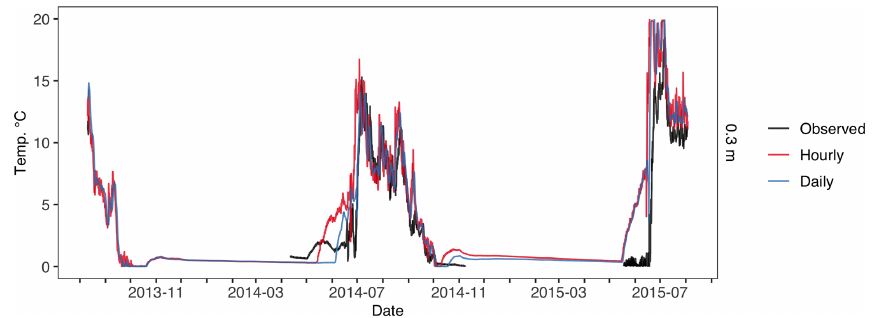
Figure F1. Atqasuk 0.3m water temperature across different temporal resolution simulations. Observed water temperature is in black, hourly temporal resolution is in red, and daily temporal resolution is in blue.